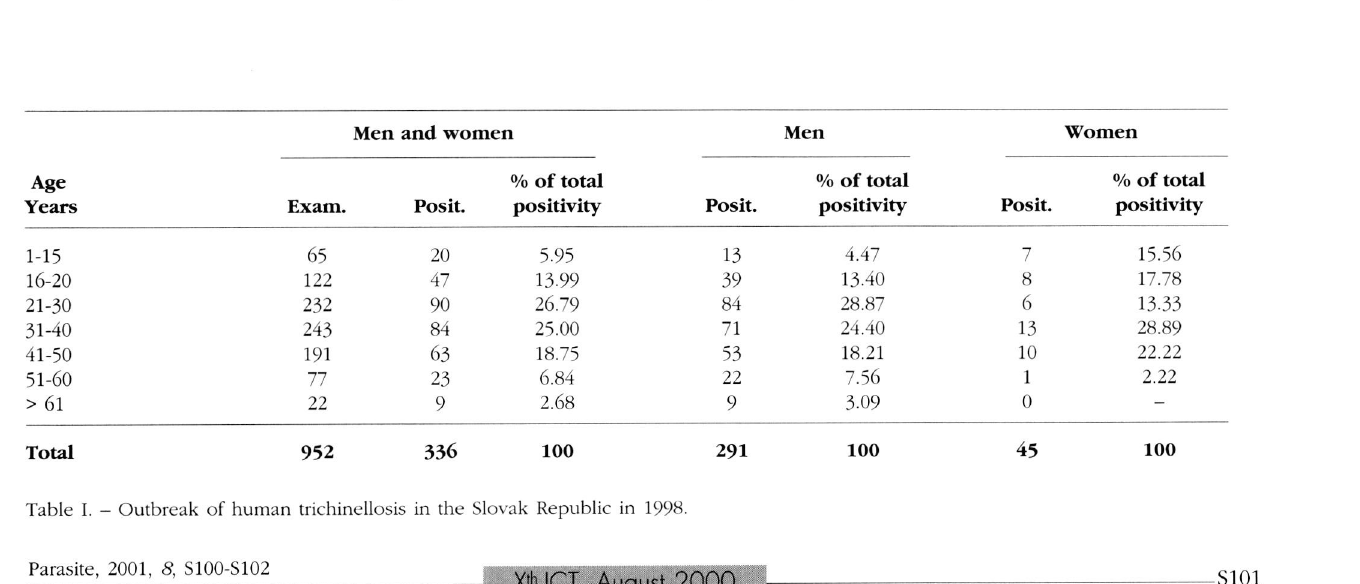
Table I. - Outbreak of human trichinellosis in the Slovak Republic in 1998.